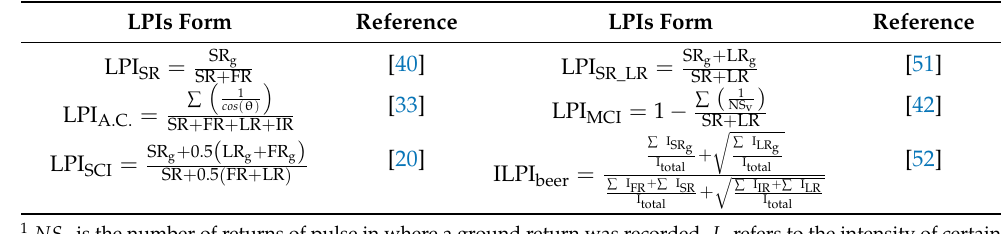
Table 2. Widely used LPIs 1.